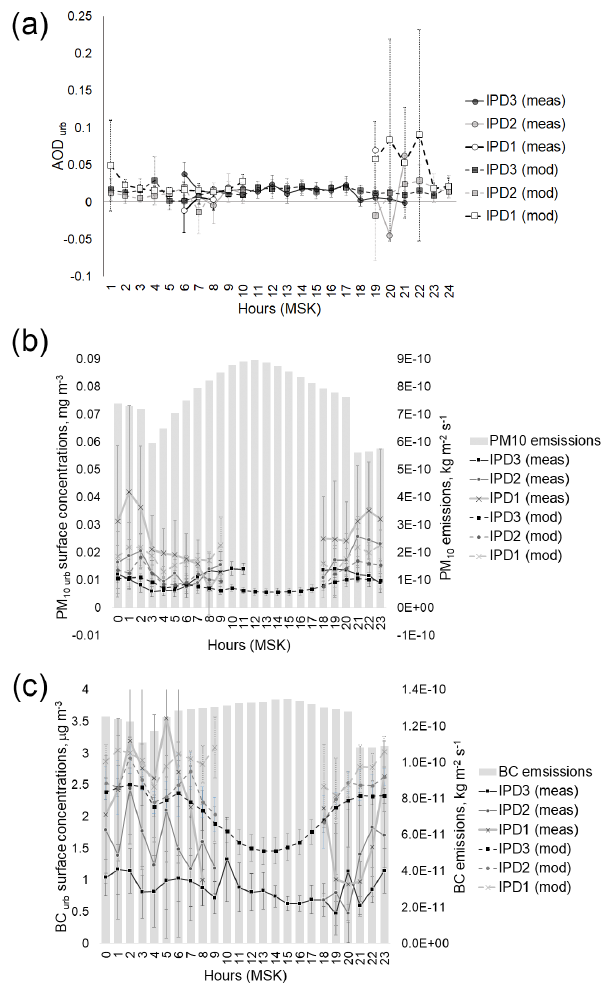
Figure 12. The composites of the diurnal cycle of AOD urb (a) , PM 10urb (b) and BC urb mass concentrations (c) according to mea- surements and modeling for different conditions of the intensity of particle dispersion (IPD). For PM 10 and BC the diurnal cycle of their emissions is also shown. The confidence intervals were calcu- lated at the 0.05 significance level.